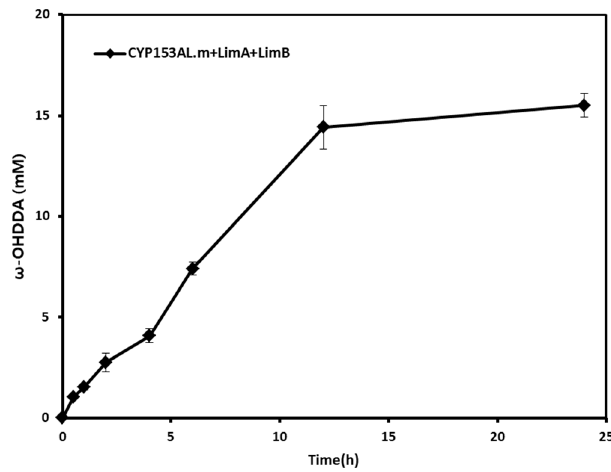
Figure 3. ω -Hydroxylation of 20 mM DDA by CYP153AL.m and LimAB containing cells. Reaction conditions: Substrate concentration, 20 mM; Volume, 10 mL in 100 mL flask; Temp, 30 °C; Cell type, BW25113 ( Δ fadD, DE3) expressing CYP153AL.m and Lim A/B; Cell OD600, 30; Phosphate buffer, 100 mM; pH, 7.5; glucose 1% ( w/v ).